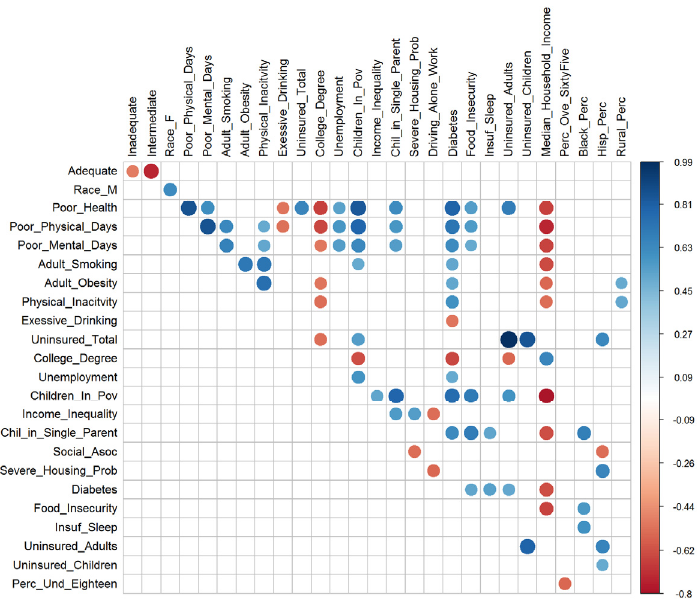
Figure 4. Correlation